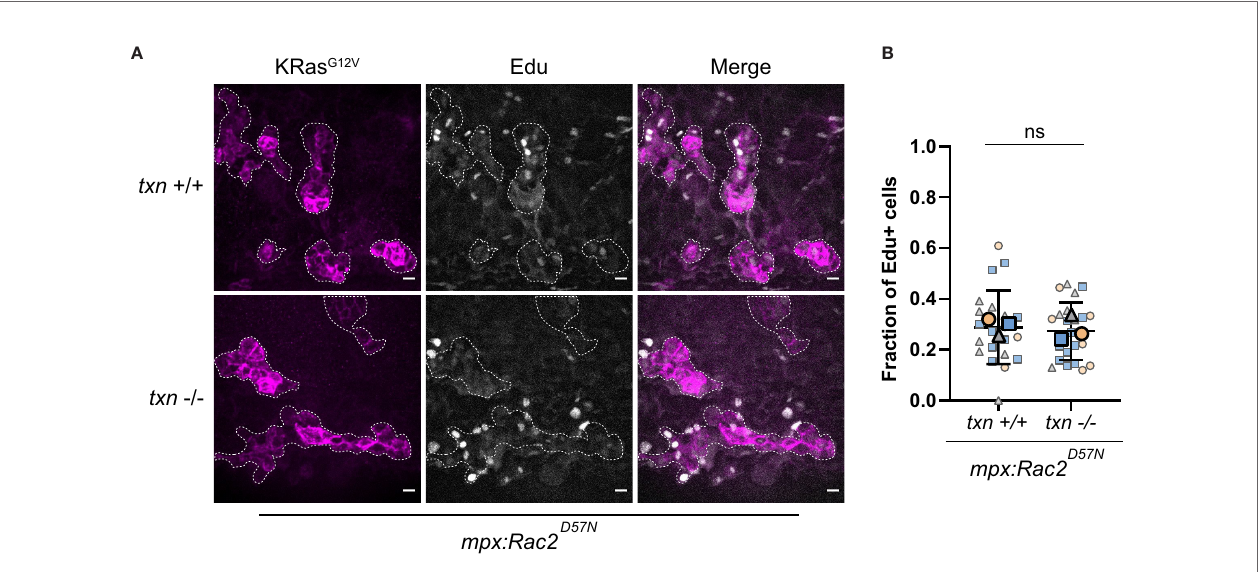
FIGURE 7 | Transformed keratinocyte proliferation is not altered in thioredoxin mutants in the absence of neutrophils. (A) EdU staining (white) of neutrophil-de fi cient Tg( mpx:Rac2 D57N -mcherry ) txn +/+ and Tg( mpx:Rac2 D57N -mcherry ) txn -/- larvae with KRas G12V -expressing basal keratinocytes (magenta) 3dpf. (B) Quanti fi cation of frequency of EdU-positive KRas G12V -expressing basal keratinocytes 3dpf in Rac2 D57N txn wt (n=21) and Rac2 D57N txn mutant (n=22) larvae. Scale bar, 10um. Bolded shapes indicate average value per technical replicate, with shaded values representing data points from independent larvae. Samples were analyzed for statistical signi fi cance via t-test ns, not signi fi